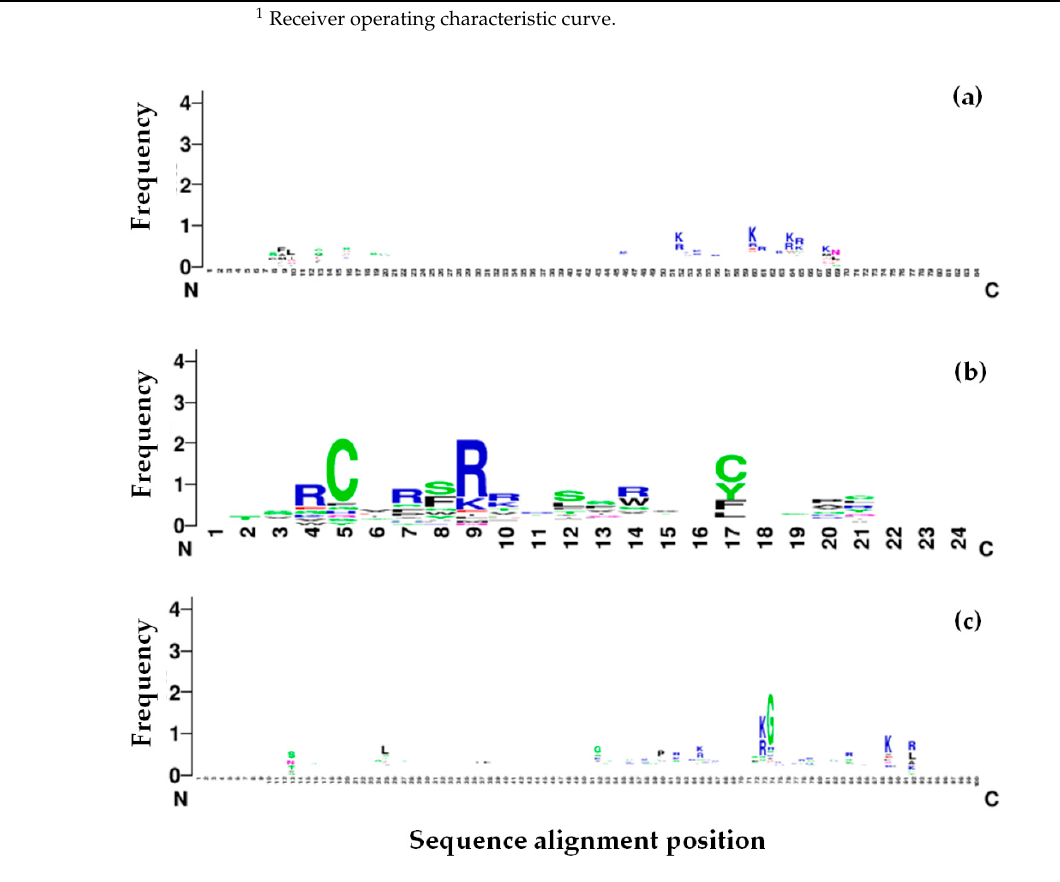
Figure 1. Multiple sequence alignment of known tyrosinase inhibitory peptides (TIPs), predicted TIPs and non-TIPs represent by the logo character plot. ( a ) predicted TIPs; ( b ) known TIPs; and ( c ) non-TIPs. Height of the amino acid characters showed the frequency that they appeared in the peptide sequences at a particular position.